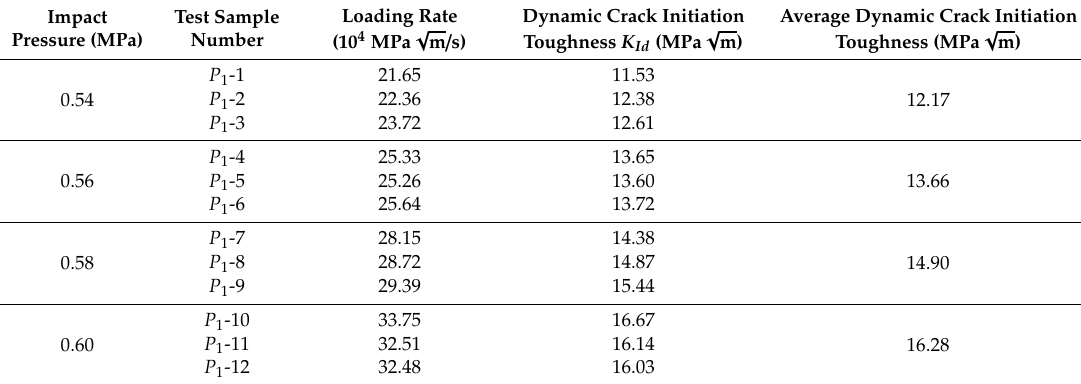
Table 3. Dynamic crack initiation toughness of shale loading with Crack-divider.